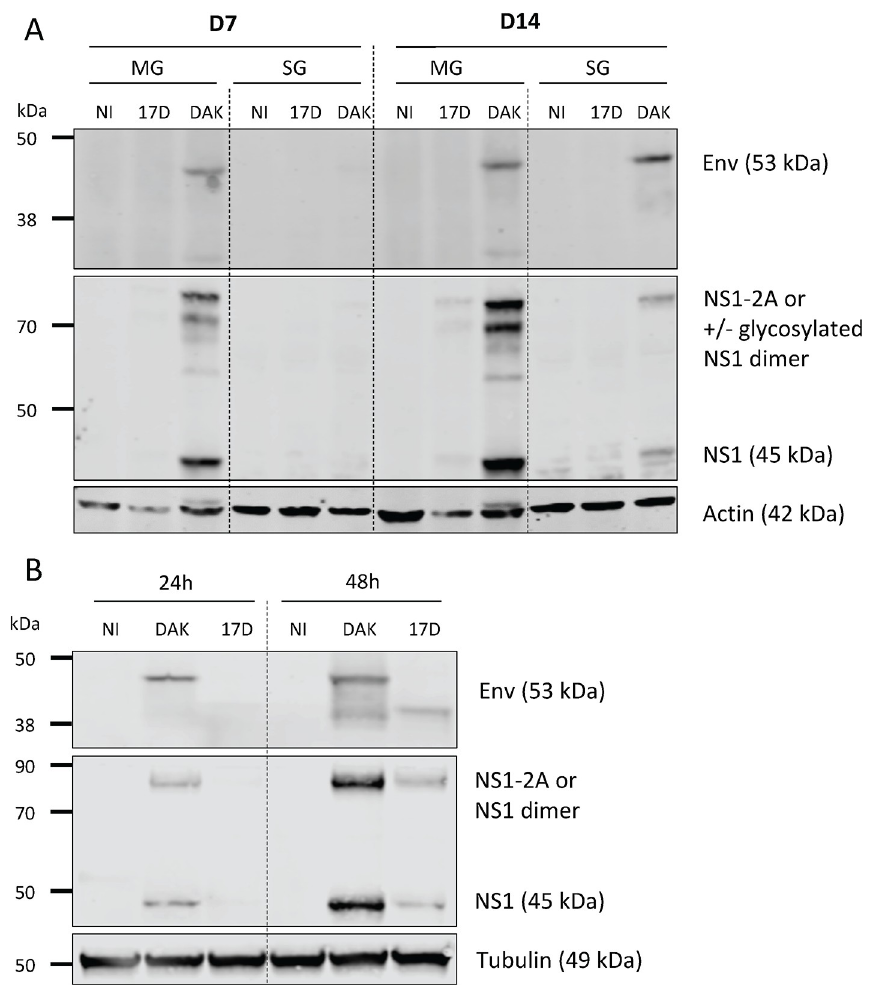
Fig 2. YFV-DAK produces detectable levels of viral proteins in infected mosquitoes. (A) Mosquitoes were fed with human blood containing 4.10 7 PFU/mL of YFV-DAK or YFV-17D or no virus (NI). The presence of viral antigens in 10 pooled midguts and salivary glands was analyzed by immunoblotting at 7 and 14 dpf using antibodies recognizing actin, viral NS1 or Env proteins. (B) Aag2 cells were infected at a MOI of 1. Whole-cell lysates were analyzed by immunoblotting at the indicated times post-infection using antibodies recognizing human tubulin, viral NS1 or Env proteins. Non-reducing condition were used to detect the Env proteins.